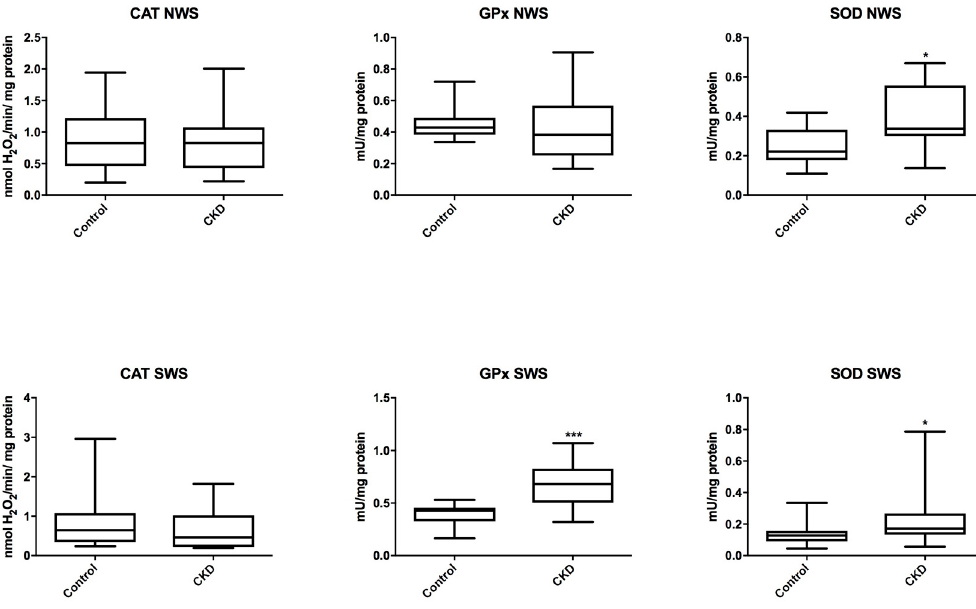
Figure 1. Salivary antioxidant enzymes in children with chronic kidney disease (CKD) and the controls. CAT, catalase; NWS, non-stimulated whole saliva; Px, salivary peroxidase; SOD, superoxide dismutase; SWS, stimulated whole saliva. Differences statistically important at: * P < 0.05, *** P < 0.0005.